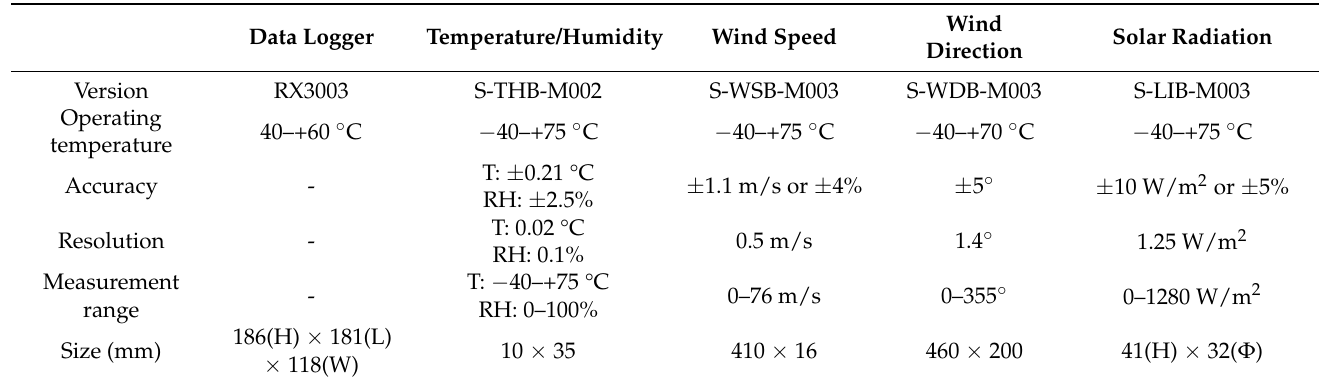
Table 1. Basic information for sensors on the microclimate